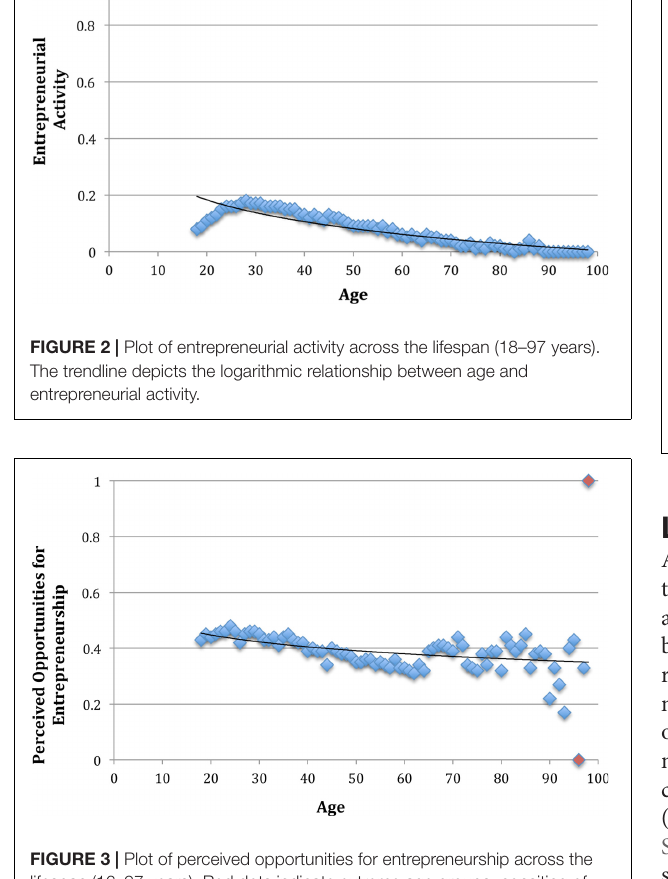
FIGURE 3 | Plot of perceived opportunities for entrepreneurship across the lifespan (16–97 years). Red dots indicate extreme age groups, consiting of very few observations (i.e., N = 2 for age 96, N = 1 for age 98). The trendline depicts the logarithmic relationship between age and perceived opportunities for entrepreneurship.